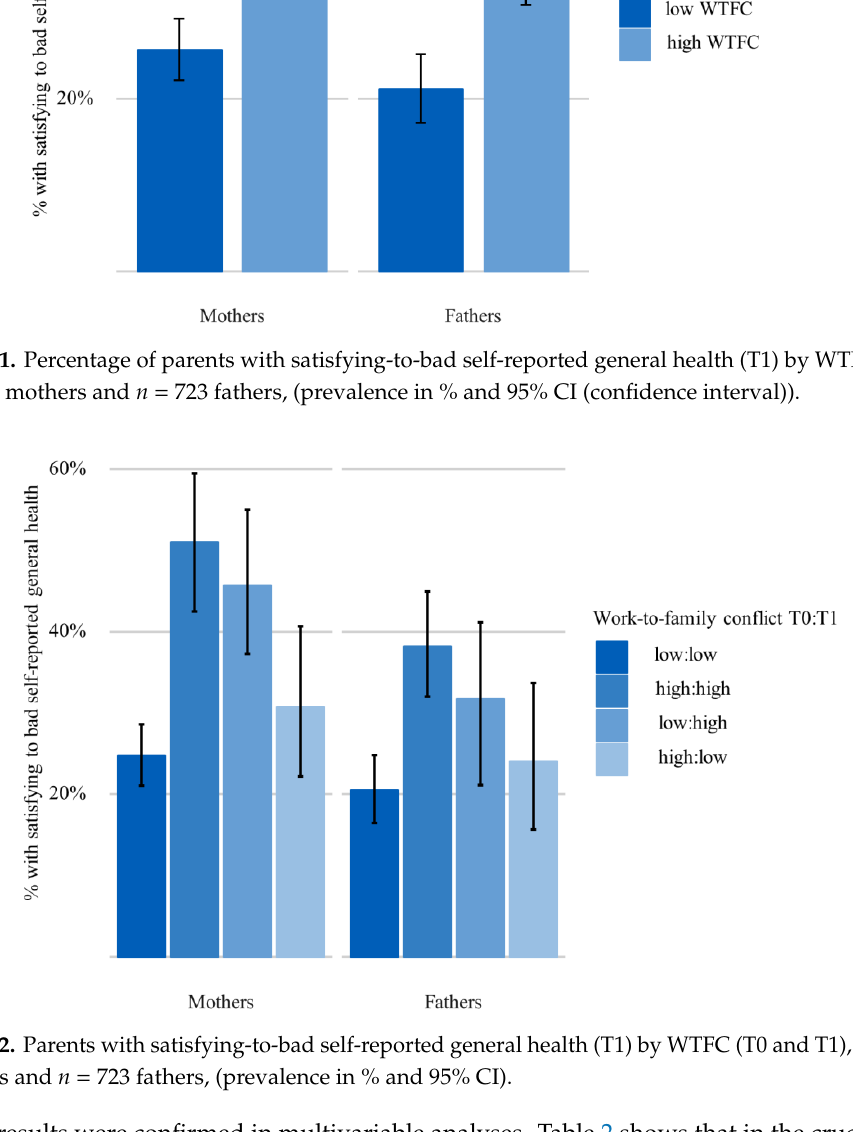
Table 2. Results from the logistic regression (odds ratio and 95% CI) with self-reported general health at T1 as the dependent and WTFC at T0 and T1 as the independent variable for mothers. WTFC Crude Model Health at T0 Sociodemographics T0:T1